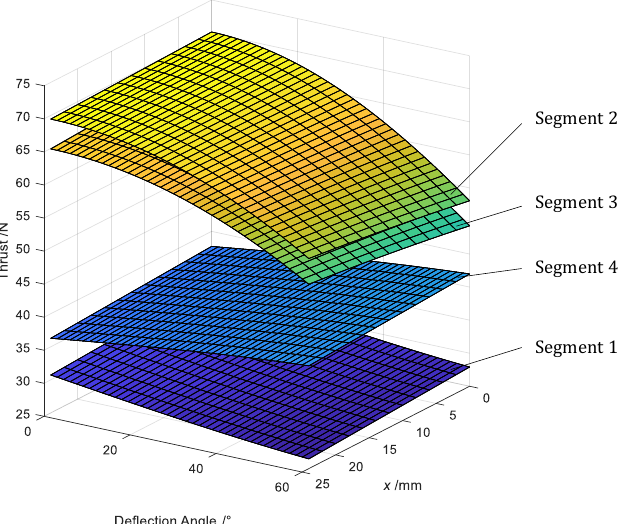
Figure 18. A diagram showing the relationship between the thrust, the deflection angles of each segment, and the cylinder elongation x . Segments 2 and 3 have relatively higher thrust and thus have better load capacity, while Segment 1 and Segment 4 should be specially designed to reduce their